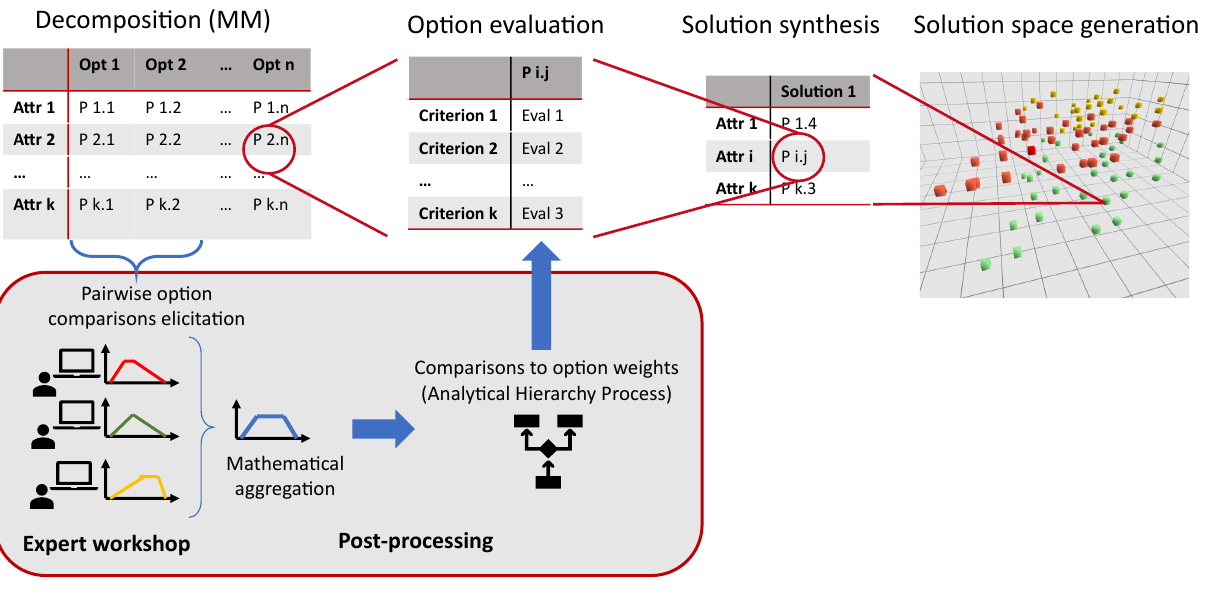
Figure 2. Main steps of the enhanced AMA including the workshop. Attr.—attribute; Opt.—option;